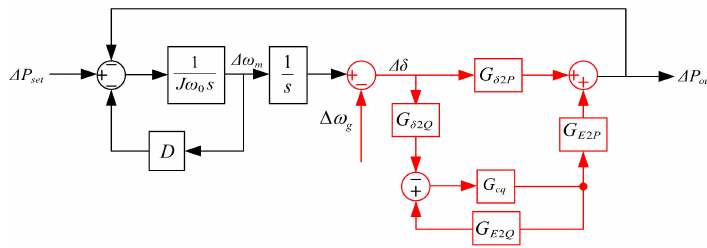
Figure 4. Active power control loop control block diagram of